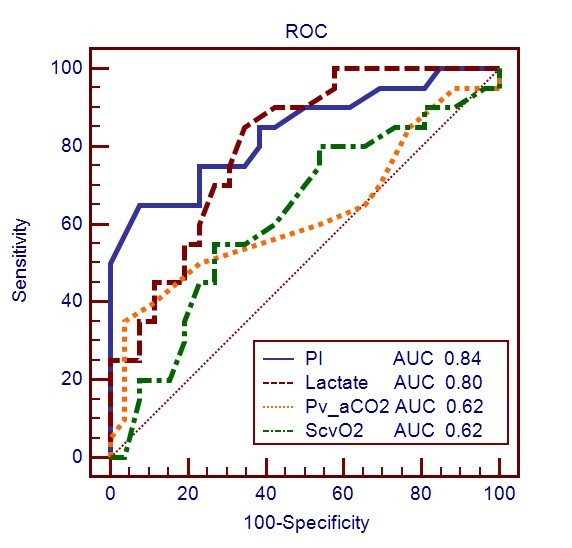
ROC curves comparing the ability of PI, lactate, Pv-a CO2 and ScvO2 to discriminate ICU mortality. PI, peripheral perfusion index measured by pulse oximetry; Pv-aCO2, difference between central venous and arterial PCO2 (mmHg); ScvO2, central venous oxygen saturation; AUC, area under the receiver operating characteristic (ROC) curve.